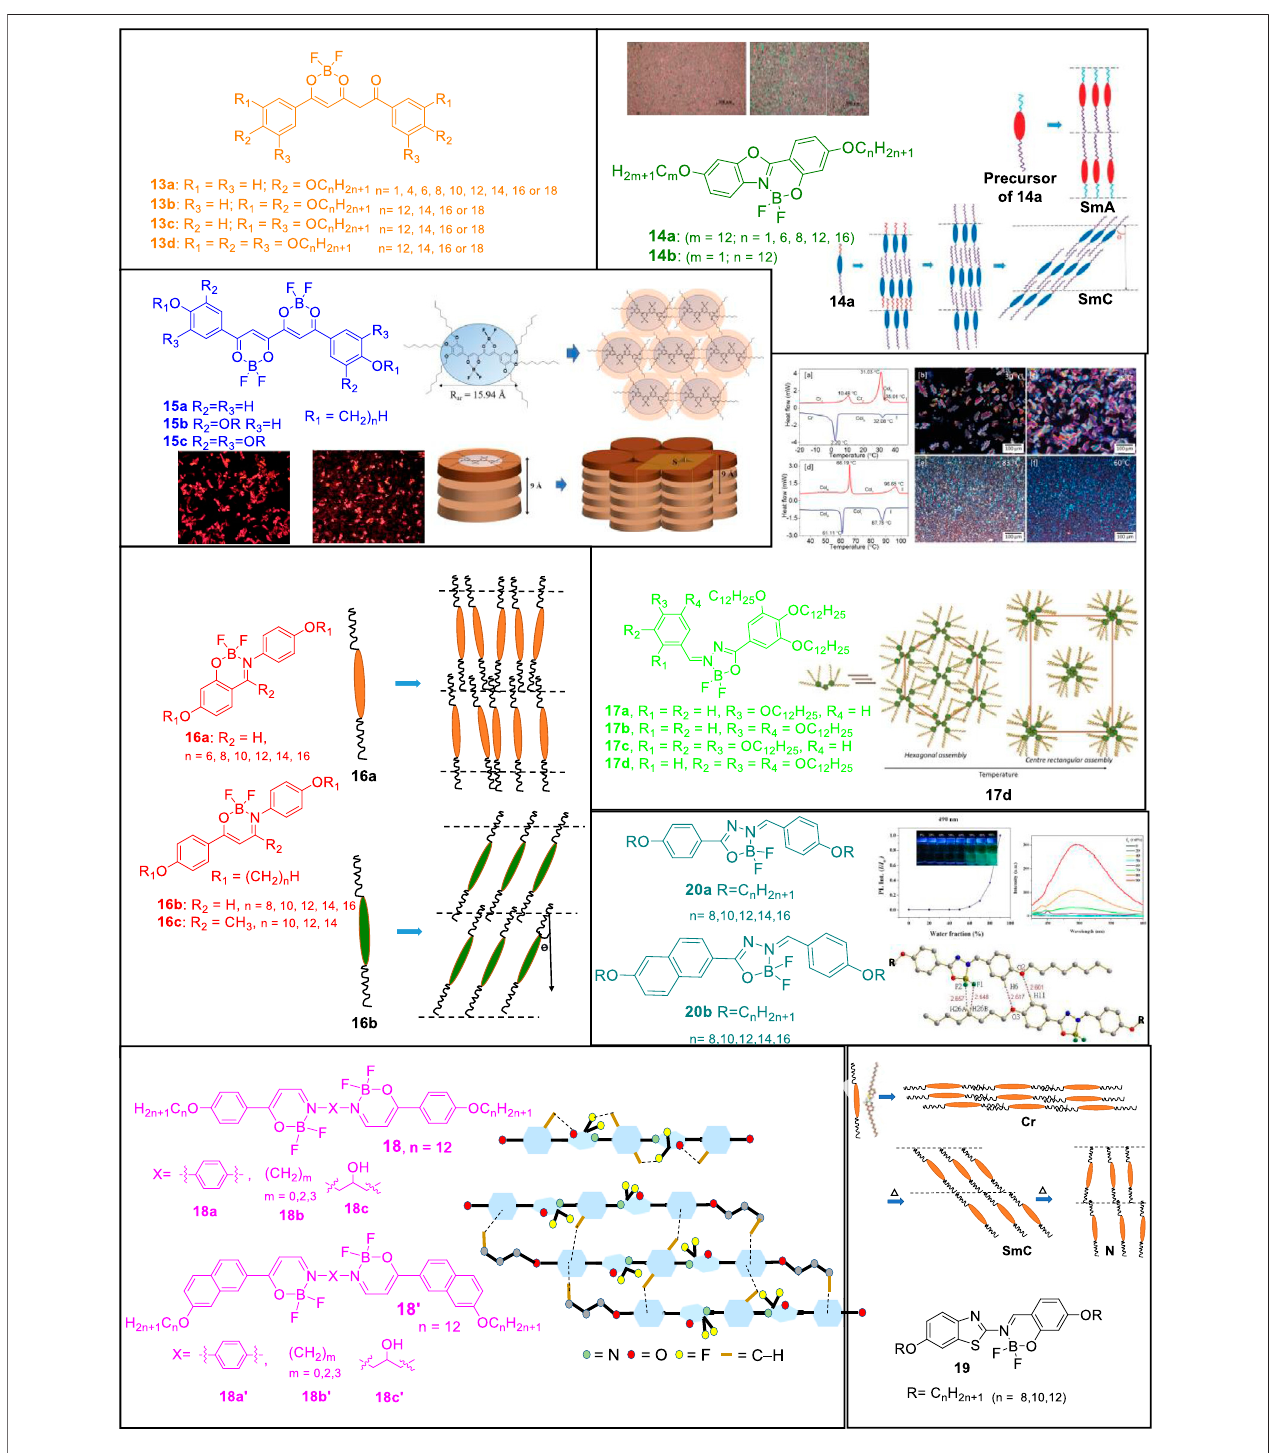
FIGURE2| Chemicalstructuresandschematicrepresentationofboron-di fl uoride compounds self-assembling intomesogens.Reproduced withpermissionfrom Chen et al., 2017a, copyright 2017 Royal Society of Chemistry. Reproduced with permission from Chen et al., 2017b, copyright 2017 Royal Society of Chemistry. Reproduced with permission from R. Vinayakumara et al., 2019, copyright 2019 Royal Society of Chemistry. Reproduced with permission from Cai et al., 2021, copyright 2021 Royal Society of Chemistry.